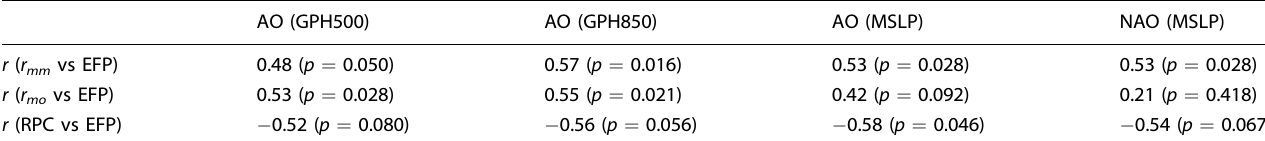
Table 1. Correlation (r) between eddy feedback parameter (EFP) and